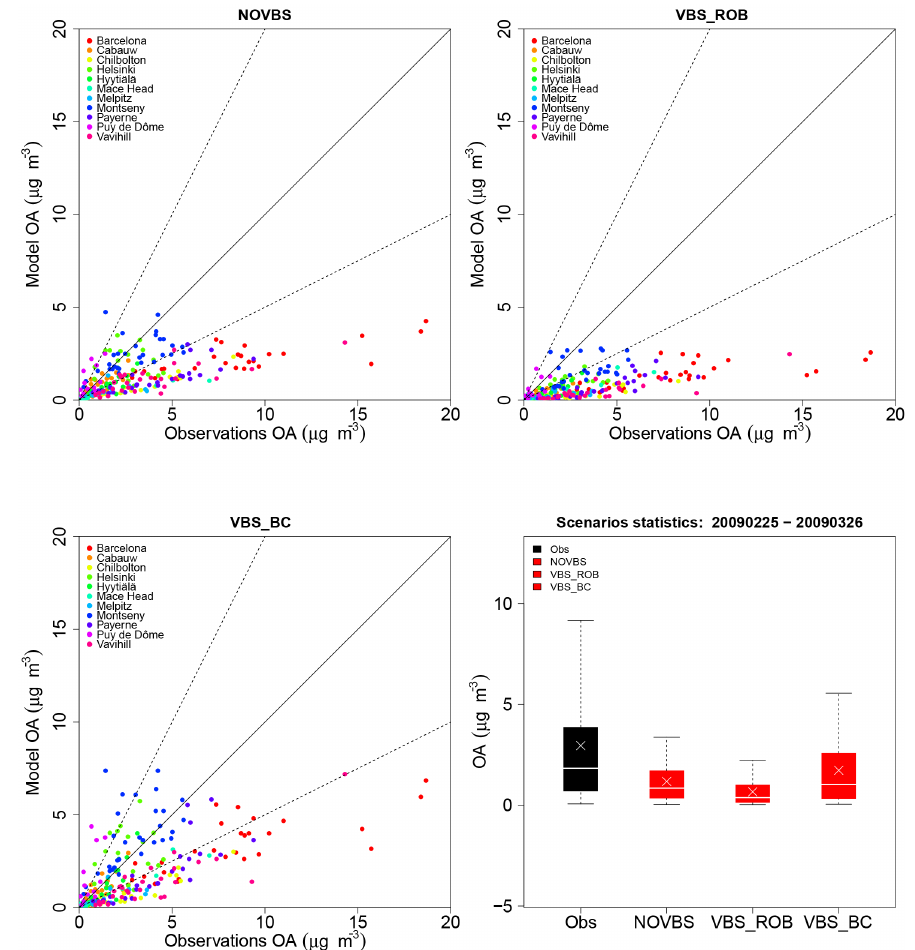
Figure 5. OA daily average scatter plots for NOVBS, VBS_ROB and VBS_BC scenarios for February–March 2009 for stations in Table 3. Solid lines indicate the 1 : 1 line. Dotted lines are the 1 : 2 and 2 : 1 lines. Box plots indicate medians, 5th, 25th, 75th and 95th quantiles for observations (black) and sensitivity tests (red). The crosses represent the arithmetic means. R 2 is 0.55 for NOVBS, 0.64 for VBS_ROB and 0.59 for VBS_BC (excluding the elevated sited of Puy de Dôme and